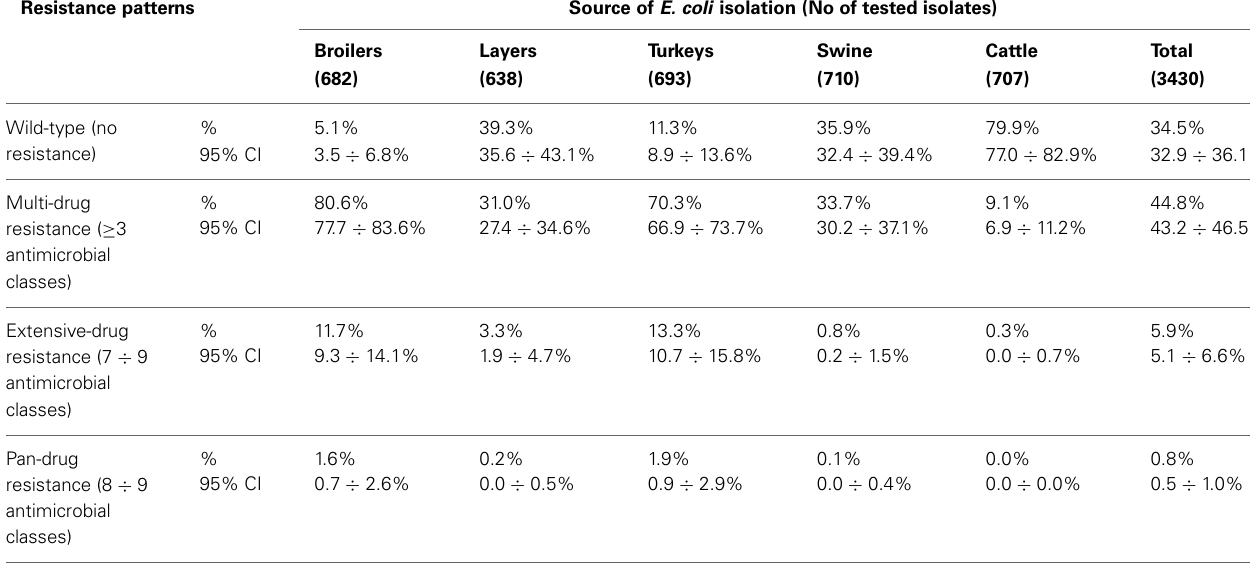
Table 4 | Complexity of resistance patterns by source of E. coli isolation. Resistance